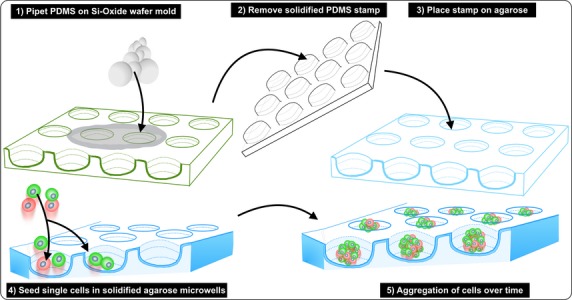
Schematic representation of agarose microwell fabrication and cell aggregation.